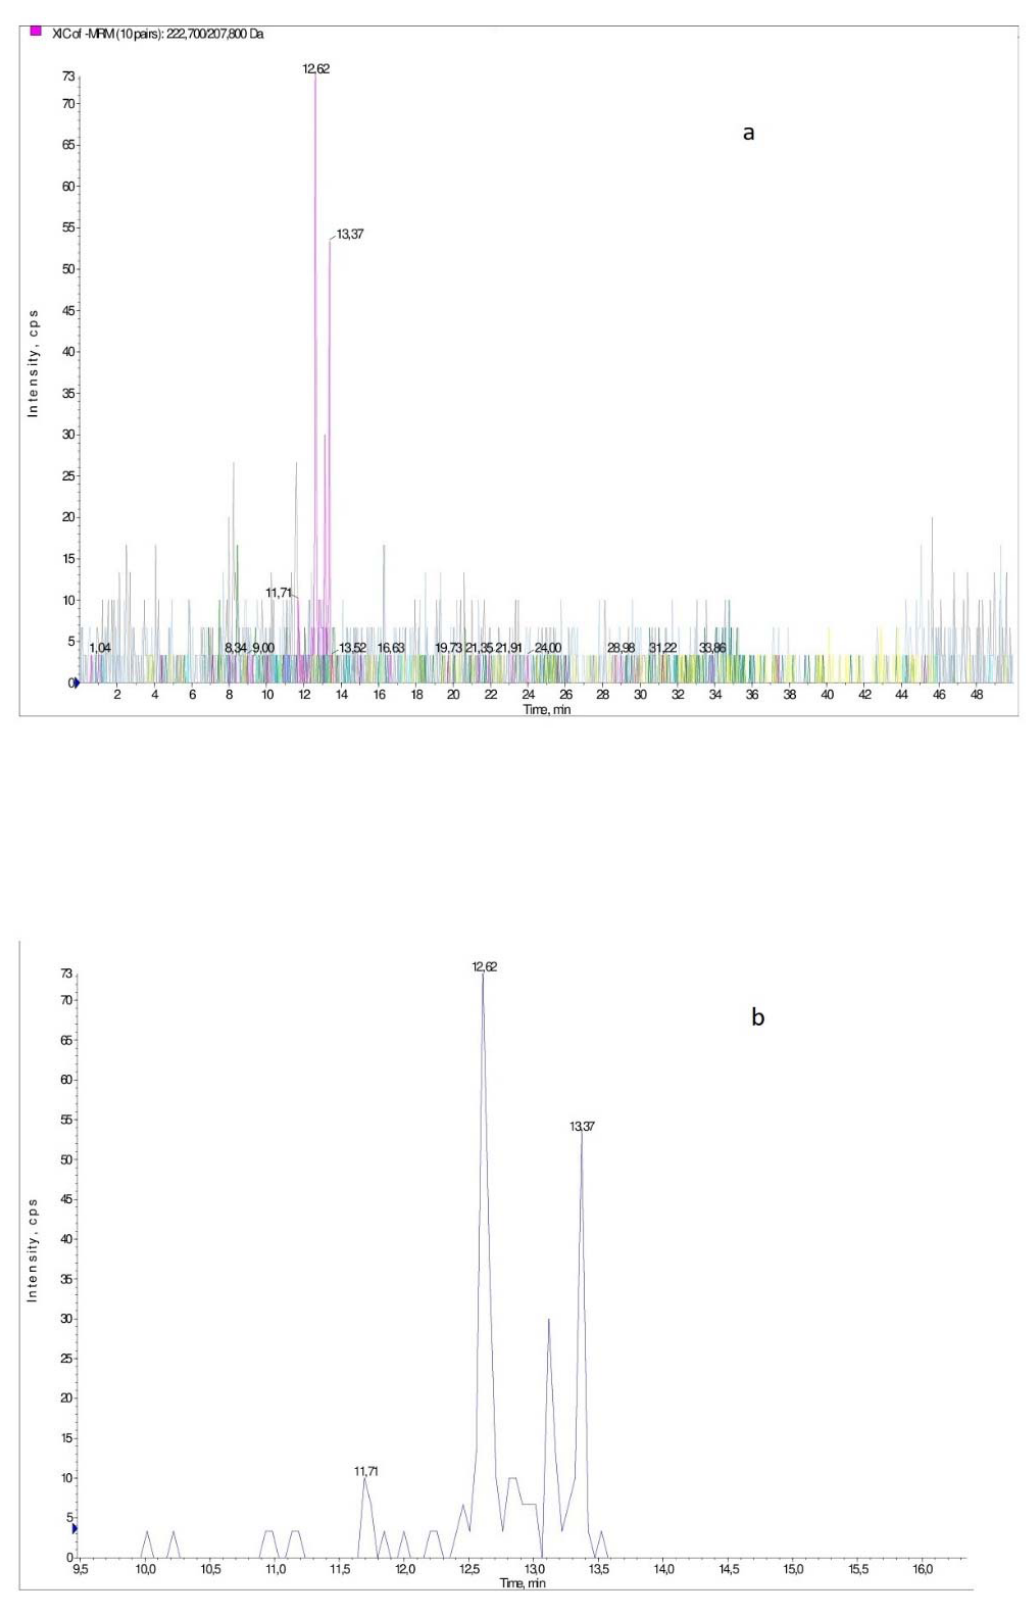
Figure 3. ( a ) The XIC chromatogram for all ionic pairs of Ornak collected in June; ( b ). Example of a XIC chromatogram obtained for sample of Ornak collected in June. The chromatogram was obtained for the ionic pair m / z = 222.7 / 207.8 which was identified as sinapinic acid.